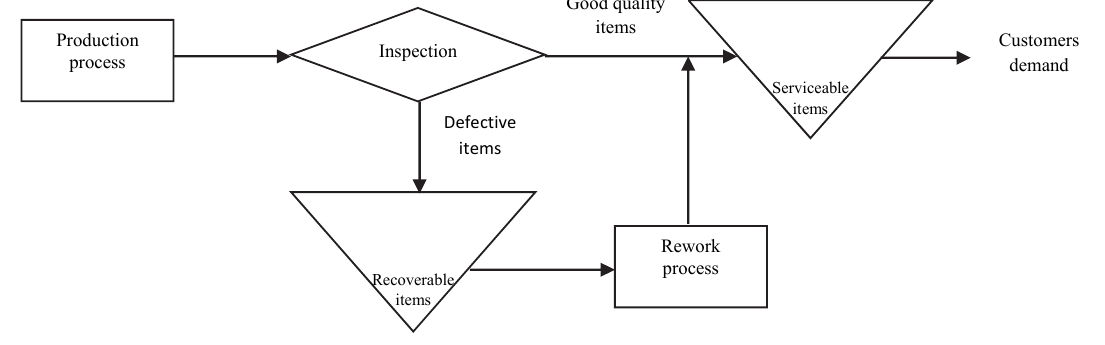
Fig. 1. The production system with